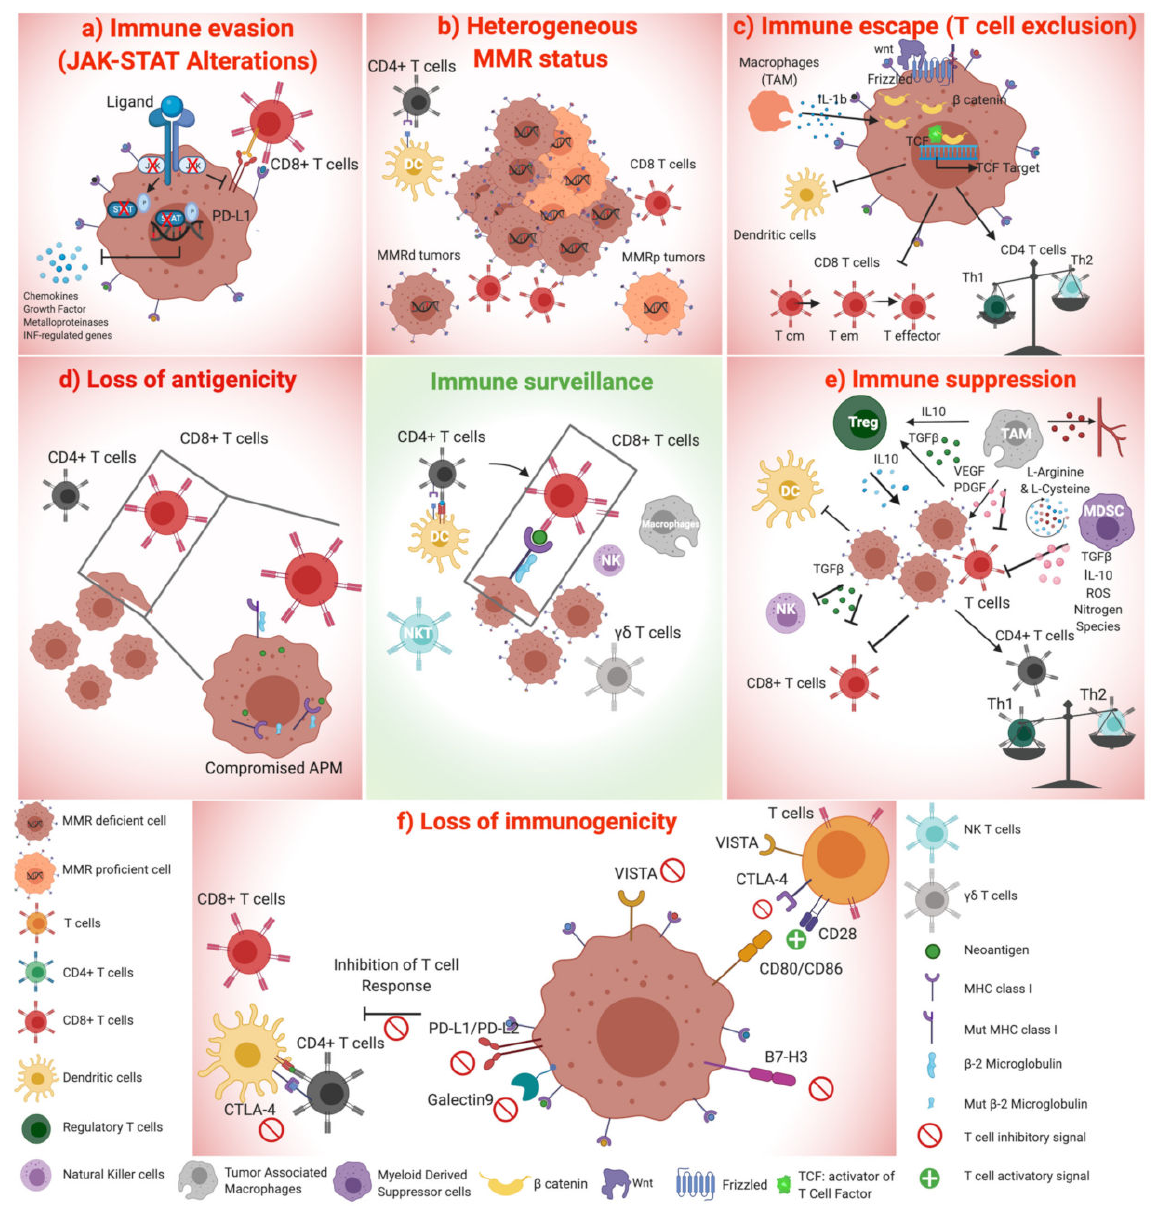
Figure 1. Genetic and non-genetic mechanisms of immune evasion in MSI tumors. MSI tumors may trigger a prolific immune response in the presence of CPIs, since they generate more tumor-specific antigens than MSS tumors, thereby inducing the immune surveillance (green panel). However, MSI tumors can deceive the immune system through several evasion patterns: ( a ) alterations in the JAK-STAT pathway compromise the immune response and negatively regulate PD-L1 expression; ( b ) MMR-deficient and -proficient neoplastic cells in the same tumor might impede the prolific response to CPIs; ( c ) the Wnt/ β catenin pathway in MSI tumors contributes to T cell exclusion, favoring the immune escape; ( d ) the loss of antigenicity, due to the acquisition of mutations in specific genes (e.g., MHC class I, B2M), compromises the opportunity to present tumor-derived antigens to the immune system; ( e ), immune suppression exerted by Tregs, MDSC, and peculiar cytokines like TGF- β and IL-10 leads to an inhibitory activity towards the immune cells with cytotoxic properties allowing tumor proliferation, vascularization, and metastasis formation. T cm (central memory T), T em (effector memory T). ( f ) tumors may lose the ability to be immunogenic mainly by the expression of inhibitory immune checkpoints (e.g., PD-L1, VISTA) that induce T cell “anergy”; several checkpoint molecules are detectable on antigen presenting cells other than on the tumor cell surface such as PD-L1, PD-L2, CD80, CD86, Galectin 9, and B7-H3. In addition, VISTA is also present on T cells. Created with